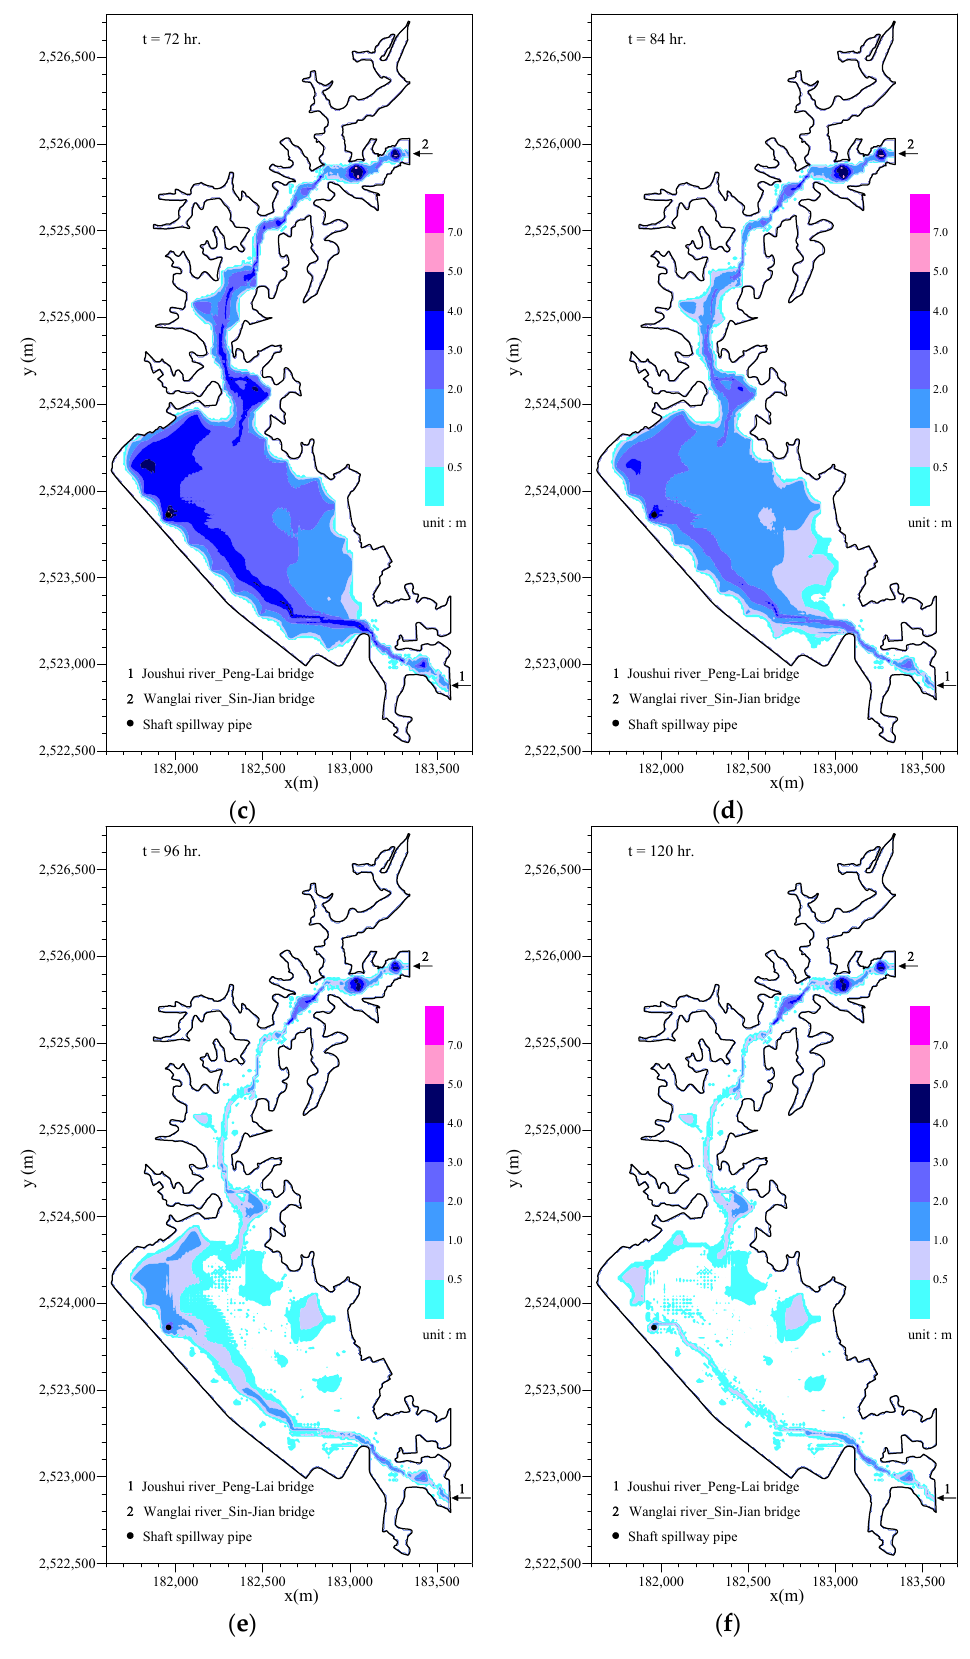
Figure 4. ( a ) Water depth in the reservoir at t = 36 h; ( b ) Water depth in the reservoir at t = 60 h; ( c ) Water depth in the reservoir at t = 72 h; ( d ) Water depth in the reservoir at t = 84 h; ( e ) Water depth in the reservoir at t = 96 h; and, ( f ) Water depth in the reservoir at t = 120 h.